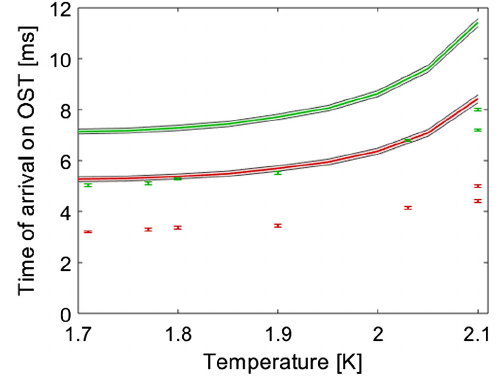
FIG. 8. Time of arrival on first (red) and second (green) OST with varying temperature: experimental data (points with error bars) and calculated data from the direct line of sight propagation (solid line). The shaded area represents the error on calculation due to geometrical measurements uncertainties.